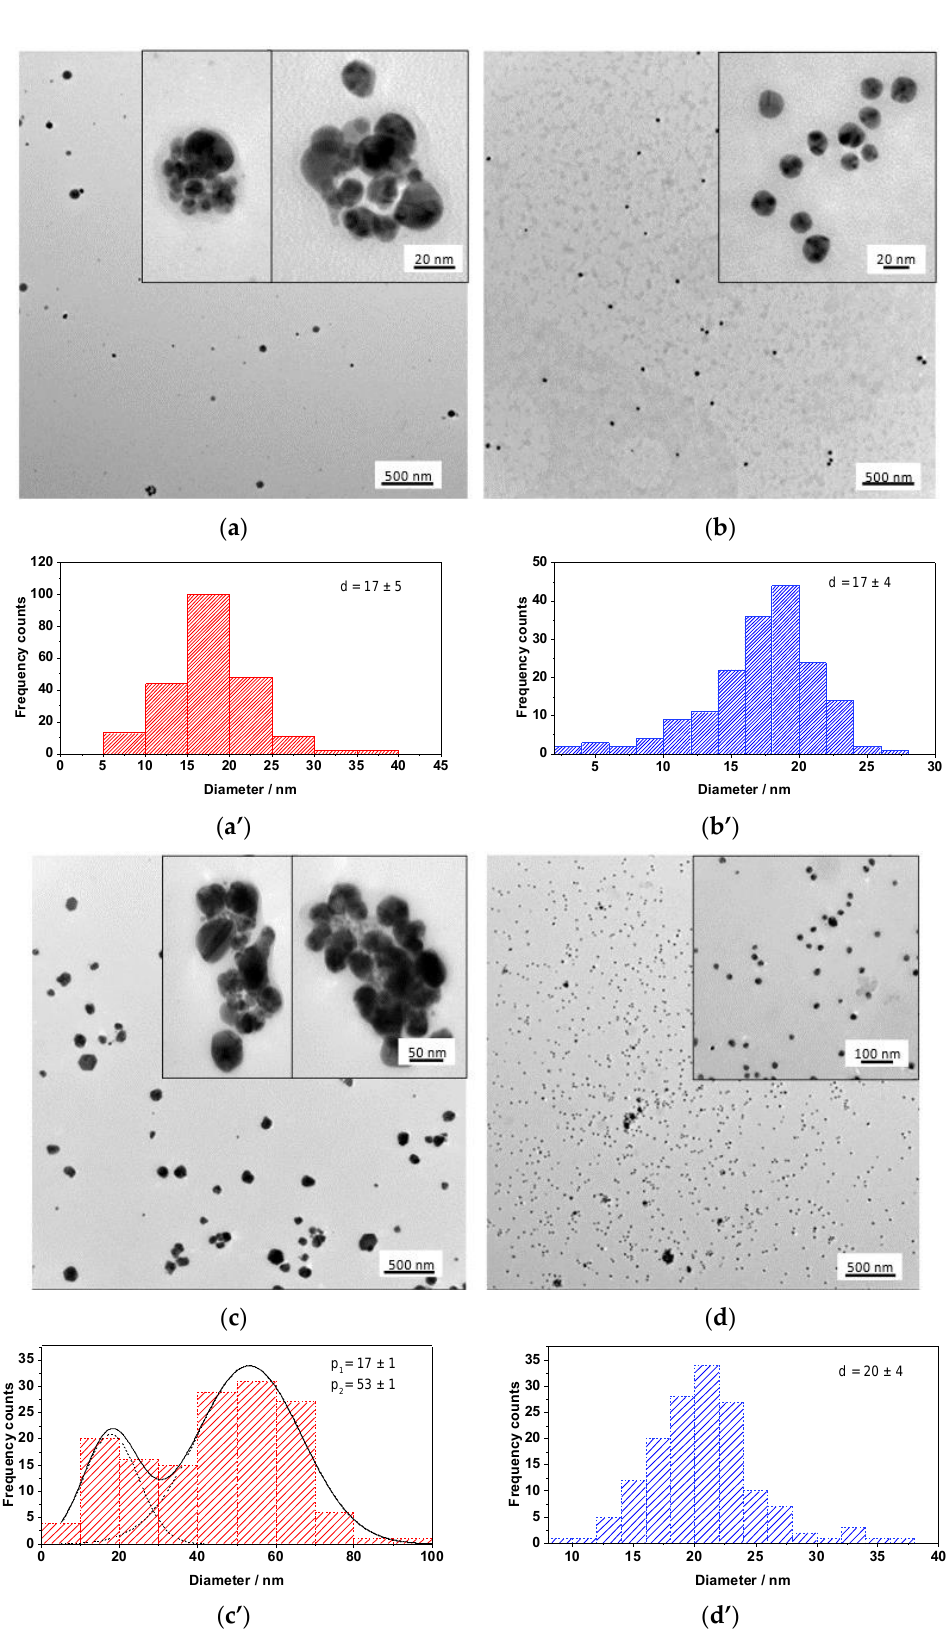
Figure 2. TEM micrographs ( a – d ) and corresponding size distribution histograms ( a’ – d’ ) of fresh ( a ) CS/TA/AgNPs and ( b ) CS/GA/TA/AgNPs nanocolloids and 6-months-aged ( c ) CS/TA/AgNPs and ( d ) CS/GA/TA/AgNPs compositions and size distributions.